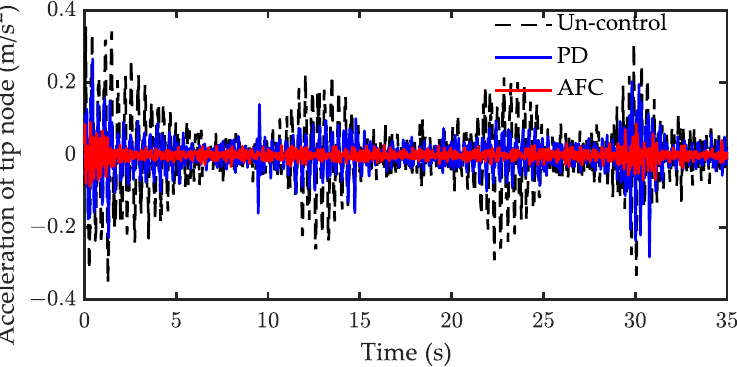
Figure 23. Experiment result of acceleration response for case 2 ( ζ = 5000).